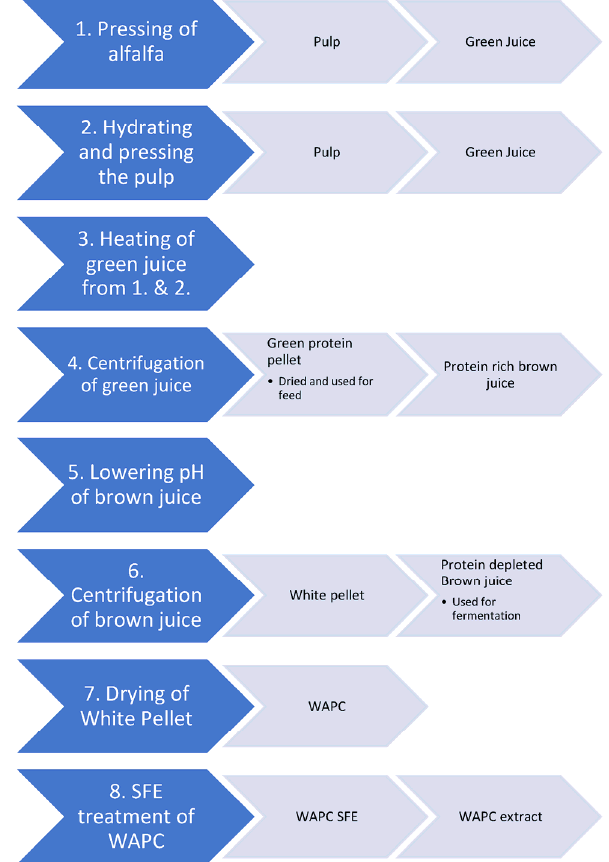
Figure 1. Process used for production of white alfalfa protein concentrate. Blue arrows = processing step, grey arrows = products from the processing step. WAPC = white protein concentrate, SFE = supercritical CO 2 extraction. When using the small twin screw press, step 2 was omitted. The level of grass aroma was observed by sniffing the protein powder after